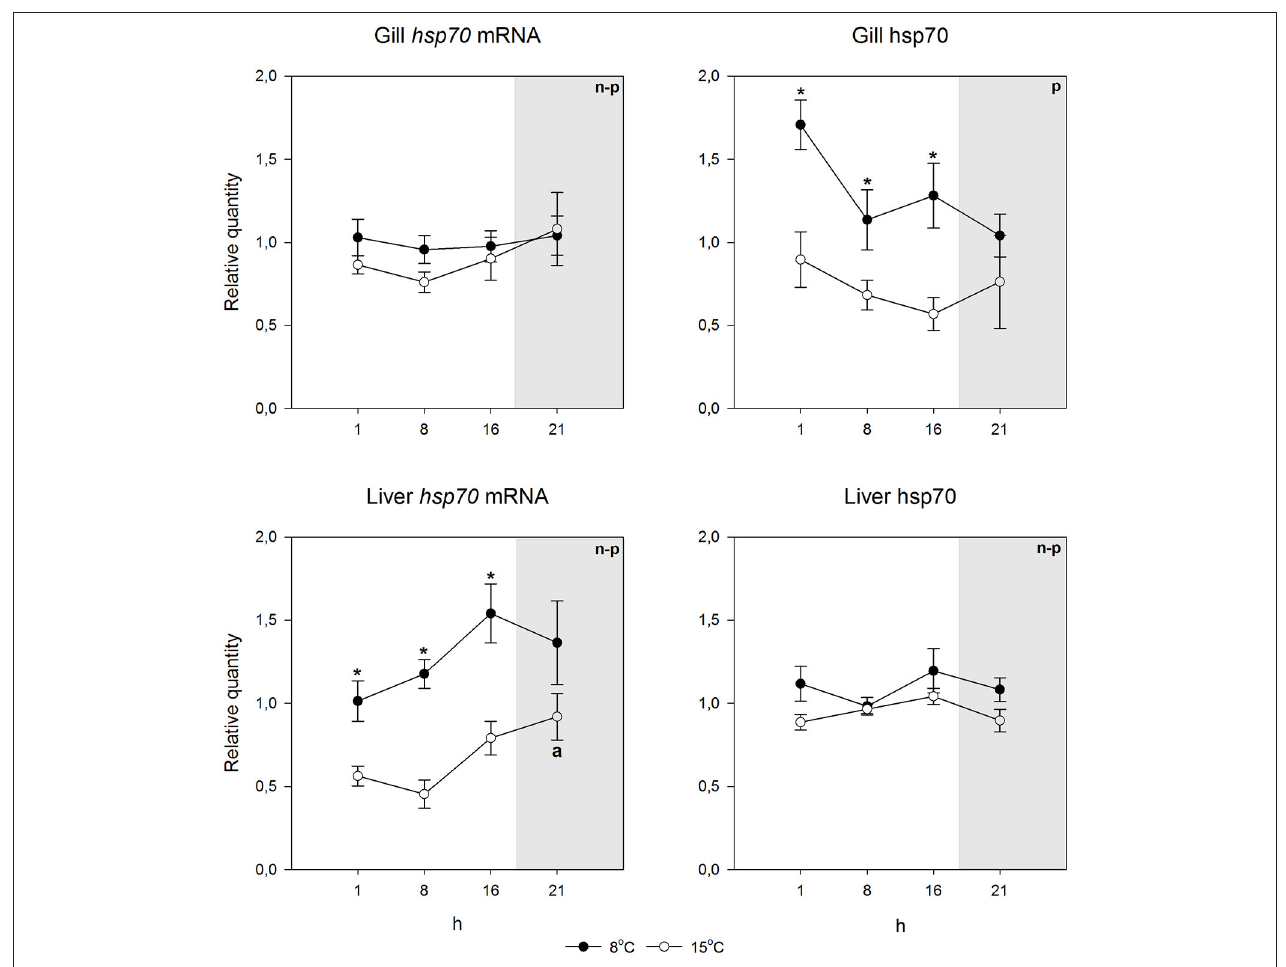
FIGURE 3 | Hsp70 mRNA and protein levels at different times of the 24-h light/dark cycle in undisturbed Atlantic salmon. Relative quantities (mean ± SEM; n = 7) are given. Whenever ANOVA or Kruskal-Wallis on ranks [parametric (p) or non-parametric (n-p), respectively] indicated statistically significant differences post-hoc testing (Holm-Sidak or Dunn’s method) was conducted. *indicates significant differences between acclimation temperatures at the same time point, and different letters indicate that the means in those time points differ from each other ( p < 0.05 was accepted as statistically significant effect). Dark period is indicated by gray